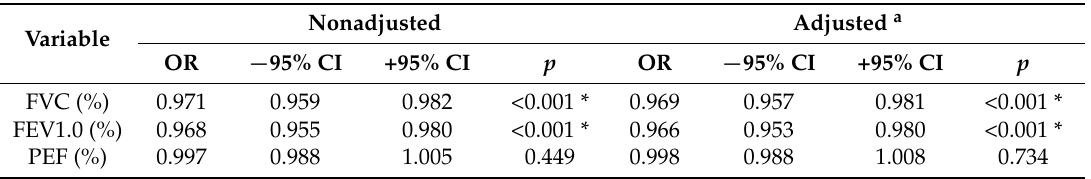
Table 2. Univariate regression analysis for patients with